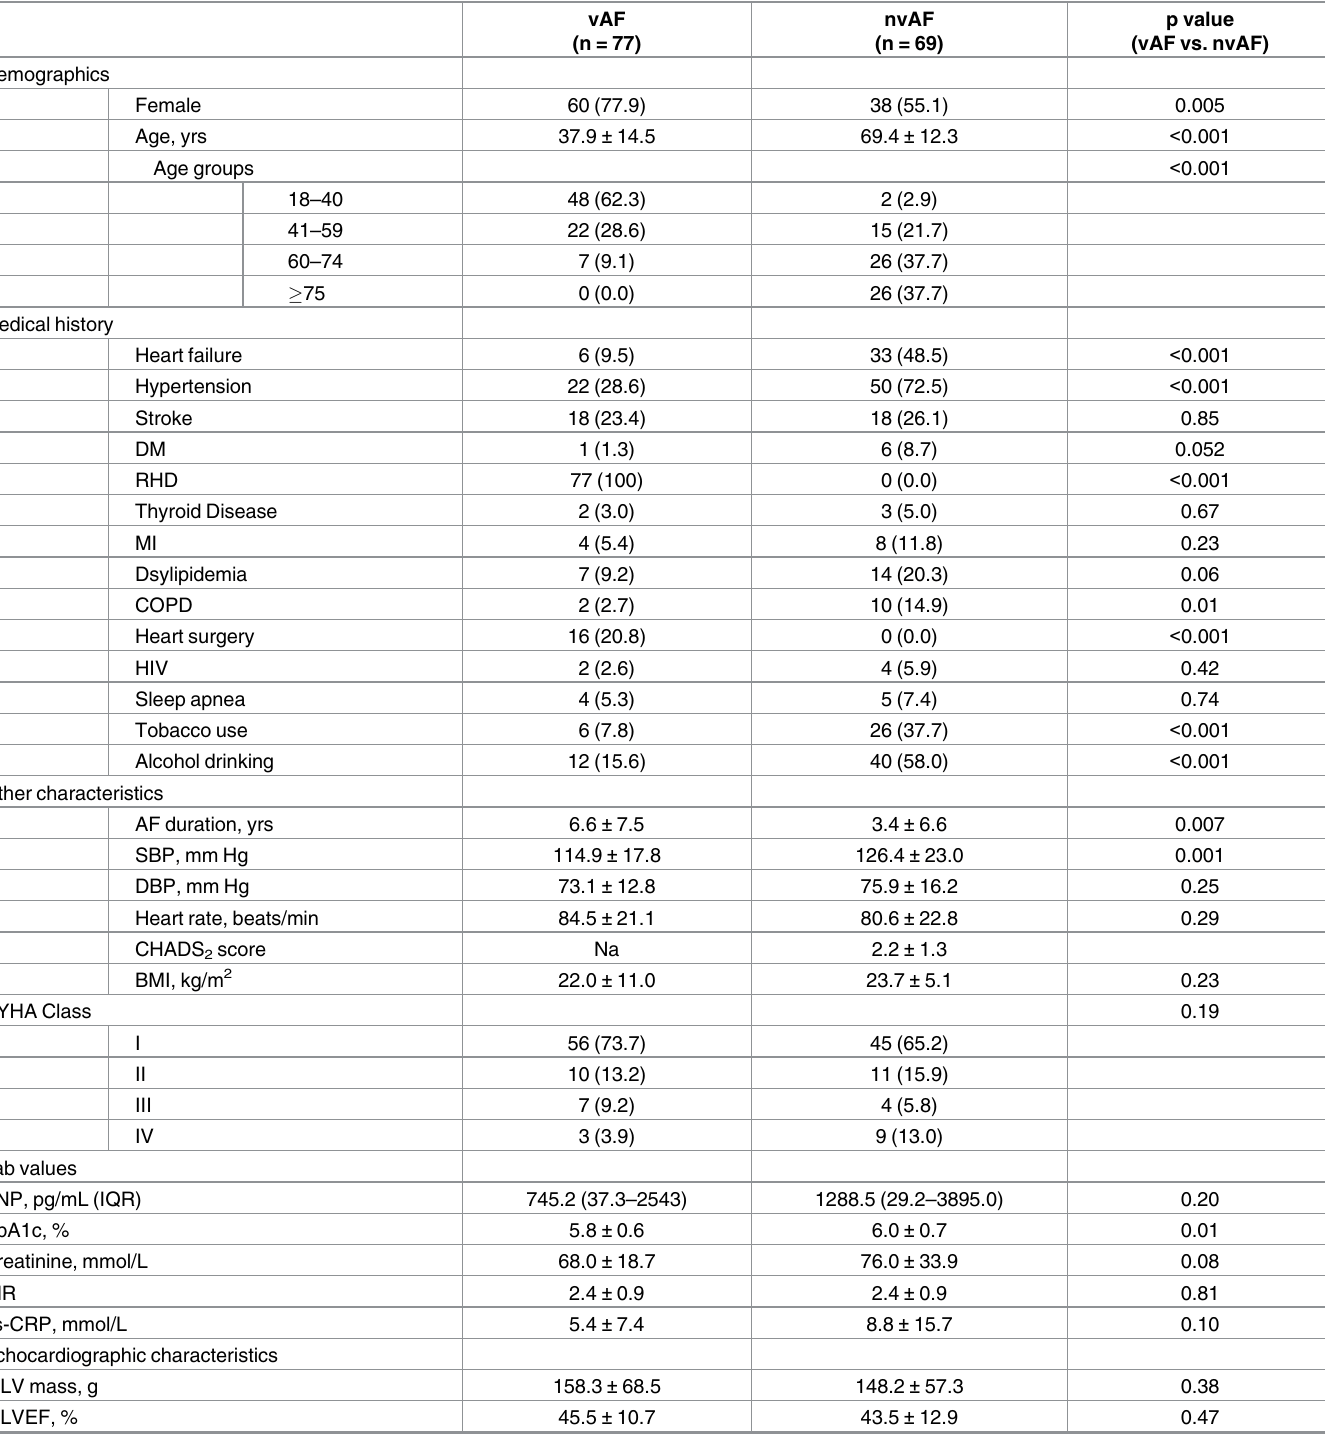
Table 1. Baseline characteristics of atrial fibrillation